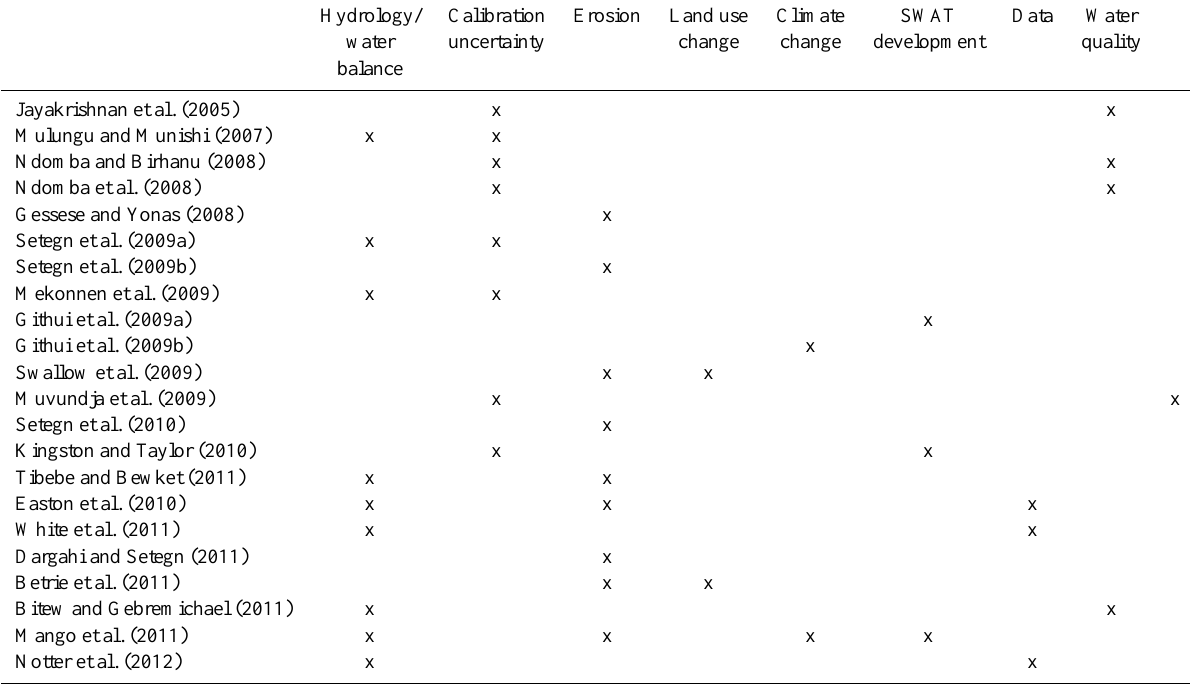
Table 1. Overview of papers describing SWAT applications in the tropical highlands of the Nile countries. Hydrology/ Calibration Erosion Land use Climate SWAT Data Water water uncertainty change change development quality